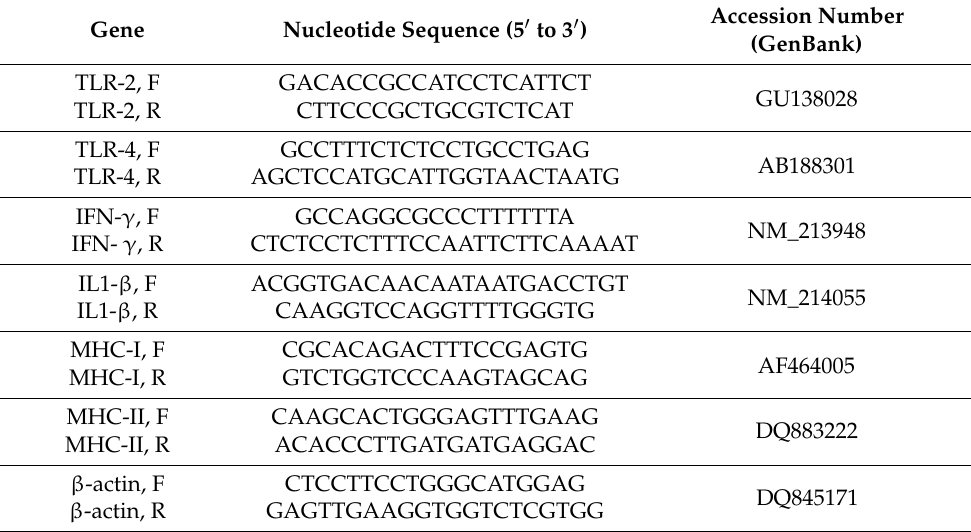
Table 2. Oligonucleotides used for PCR reactions.